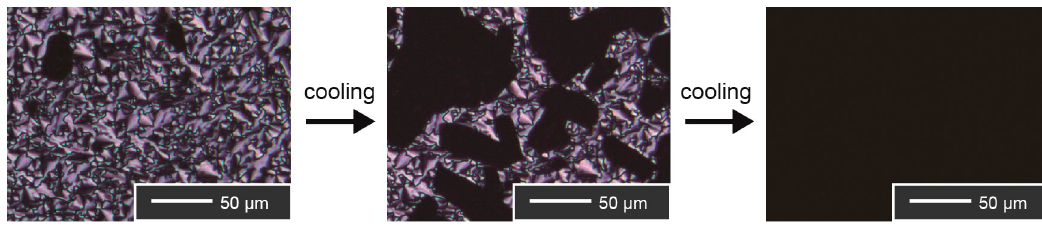
Figure 4. Polarizing optical microscopic images of the 1 /LiBF 4 (X = 0.09) mixture on the phase transition from the Col to the Cub bi phase.